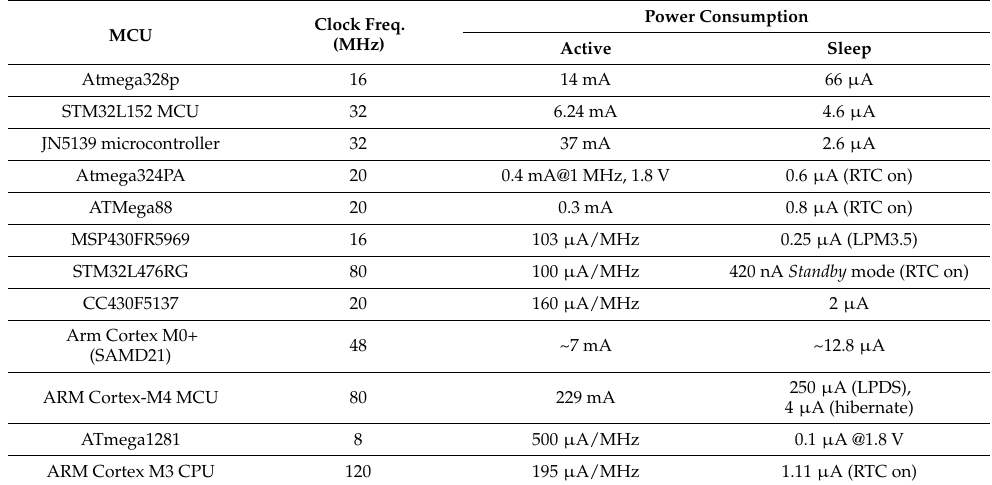
Table 3. Power consumption of different